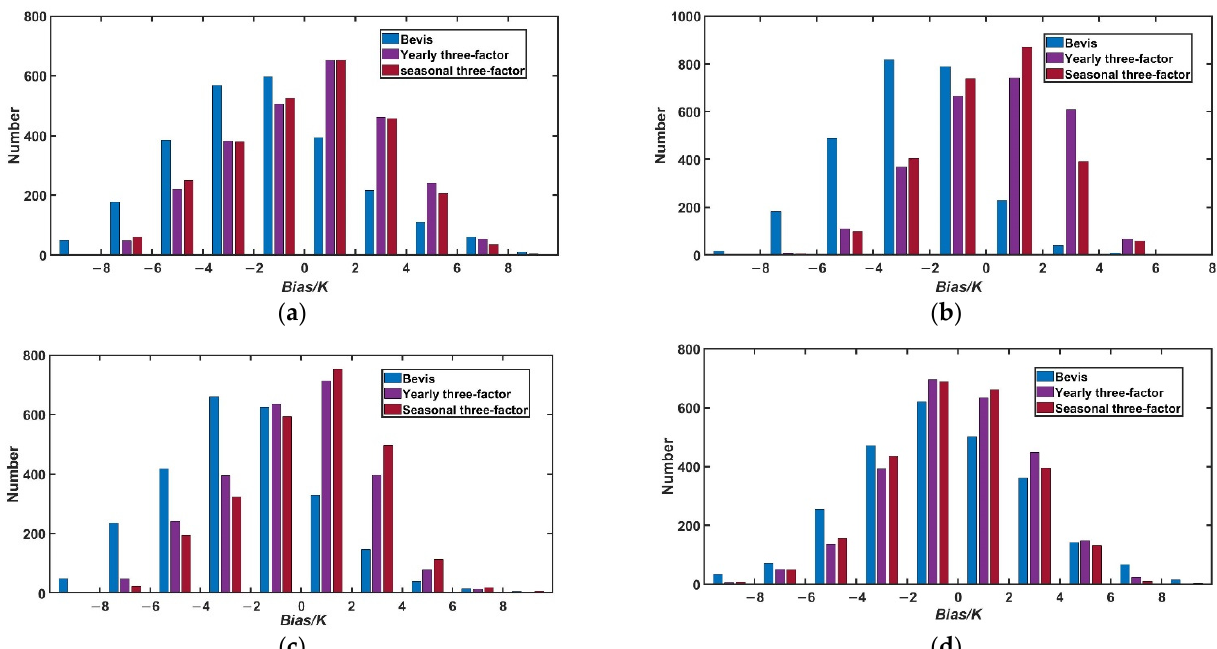
Figure 6. The statistical histograms of the biases of Bevis model, yearly and seasonal three-factor RTMs in spring ( a ), summer ( b ), autumn ( c ) and winter ( d ).